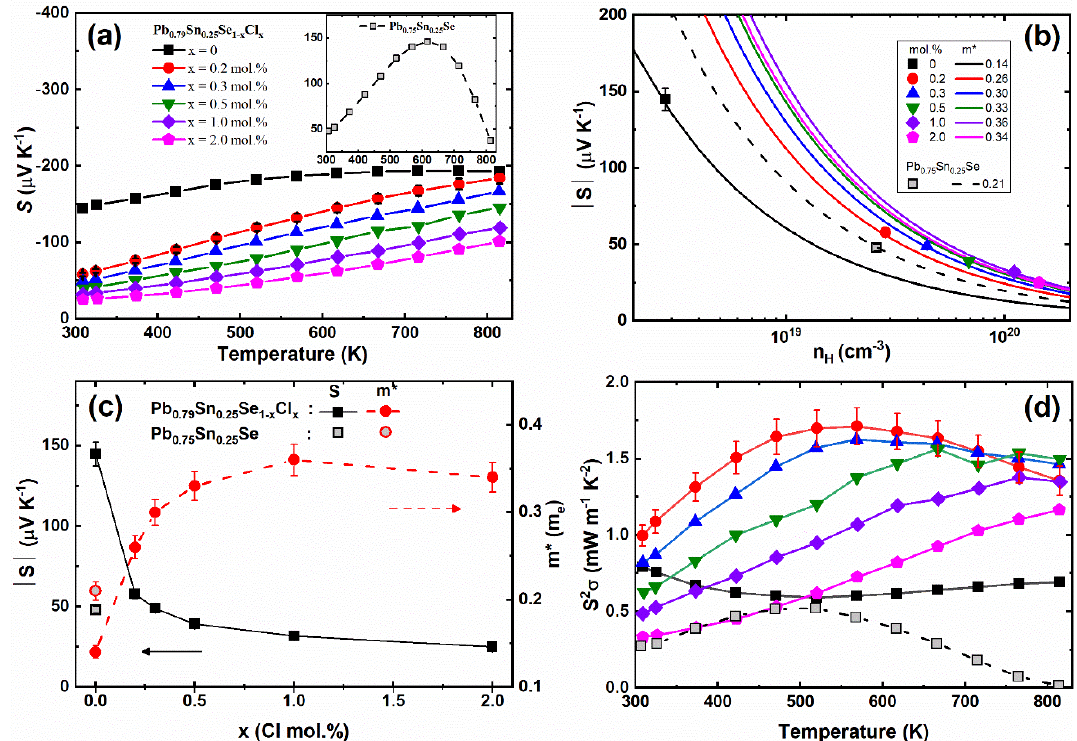
Figure 4. ( a ) Temperature-dependent Seebeck coefficient S(T) ; ( b ) room temperature Seebeck coefficient as a function of the Hall carrier concentration; ( c ) Seebeck coefficient and effective mass of carrier as a function of the Cl-doping concentration; ( d ) Temperature-dependent power factor S 2 σ of the Pb 0.79 Sn 0.25 Se 1 − x Cl x (x = 0.0, 0.2, 0.3, 0.5, 1.0, 2.0 mol.%) and Pb 0.75 Sn 0.25 Se compounds.